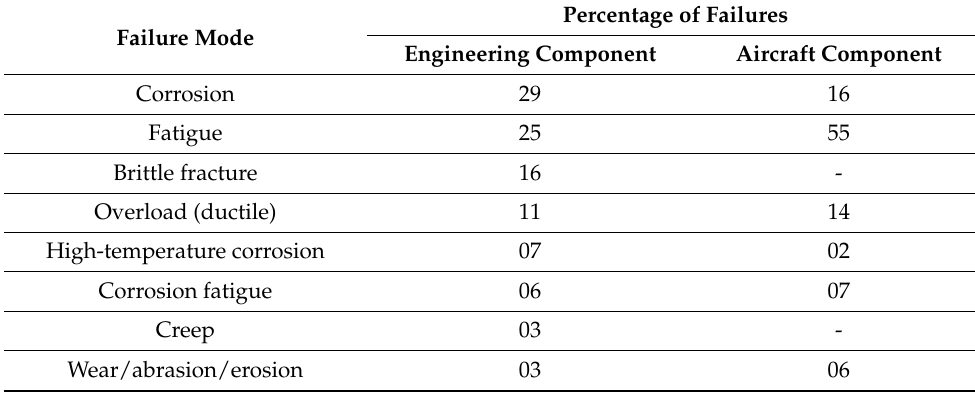
Table 1. Frequency of failure modes in aircraft components [3]. Percentage of Failures Failure Mode Engineering